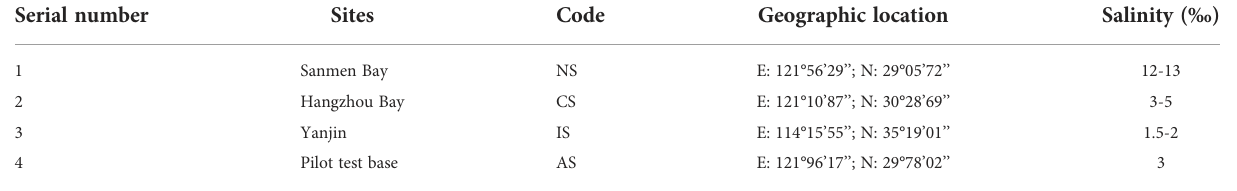
TABLE 1 Sampling points information in this